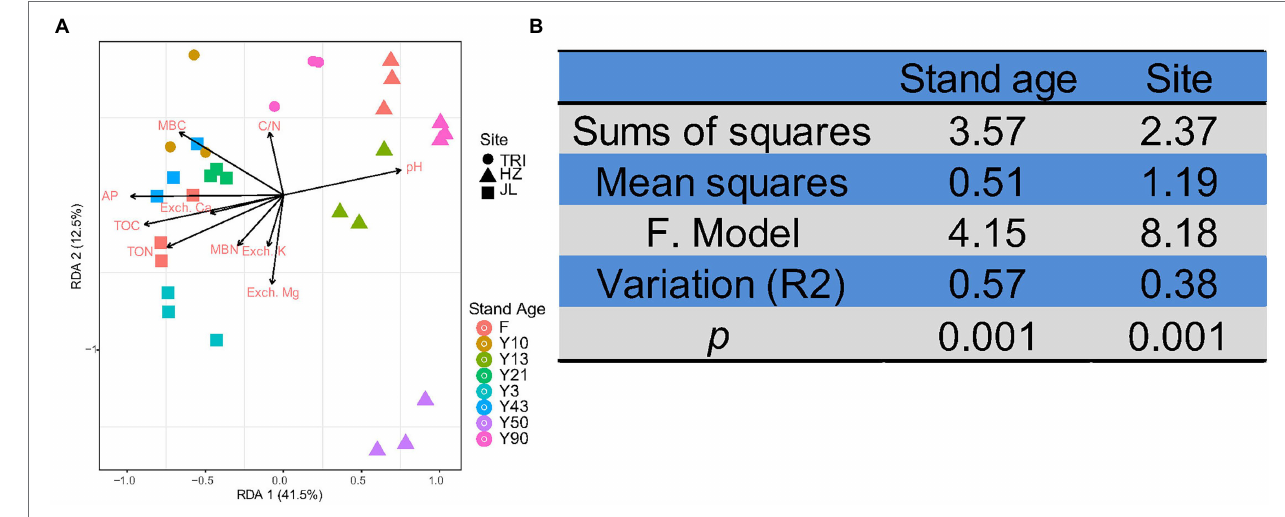
FIGURE 6 | (A) Distance-based redundancy analysis (RDA) of the relationships between soil physicochemical properties and bacterial communities at different sites and stand ages. The samples are separated by sites (TRI, HZ, and JL; represented by different shapes) and stand ages [including the adjacent forest (F); represented by different colors]. (B) The effects of stand age and sampling site on soil bacterial communities of tea plantations based on permutation multivariate analysis of variance